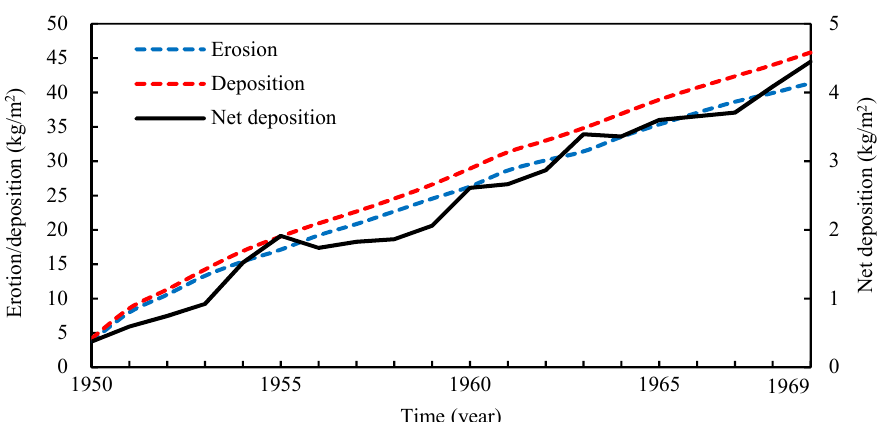
Figure 8. Amounts of erosion (blue dashed line), deposition (red dashed line) and net deposition (solid black line) per unit area for the QL system from 1950 to 1969.